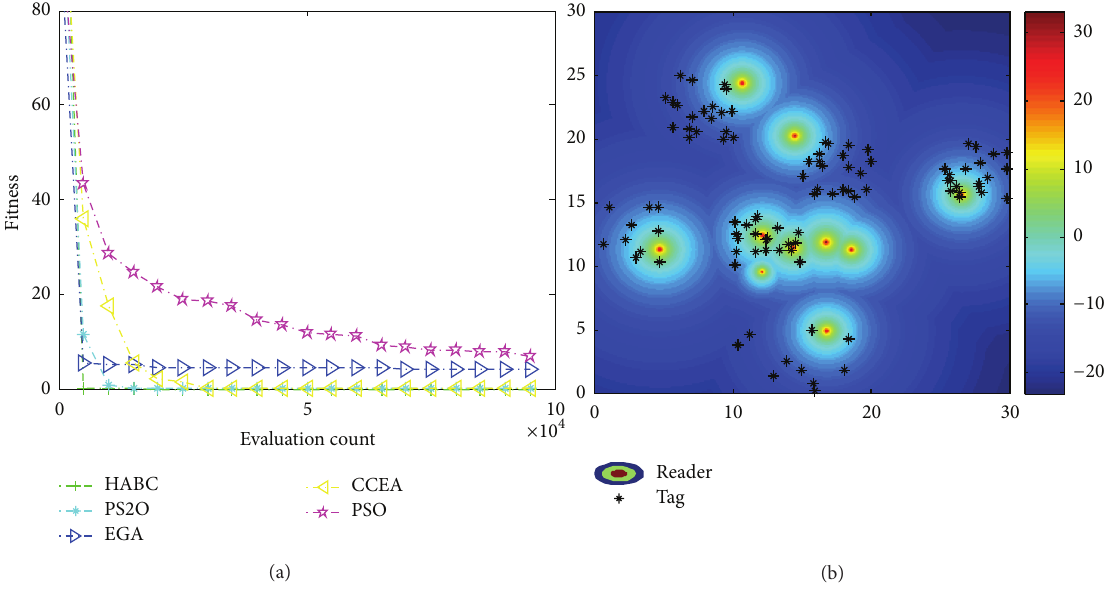
Figure 12: Results only consider load balance. (a) Convergence process; (b) reader location and received power distribution.